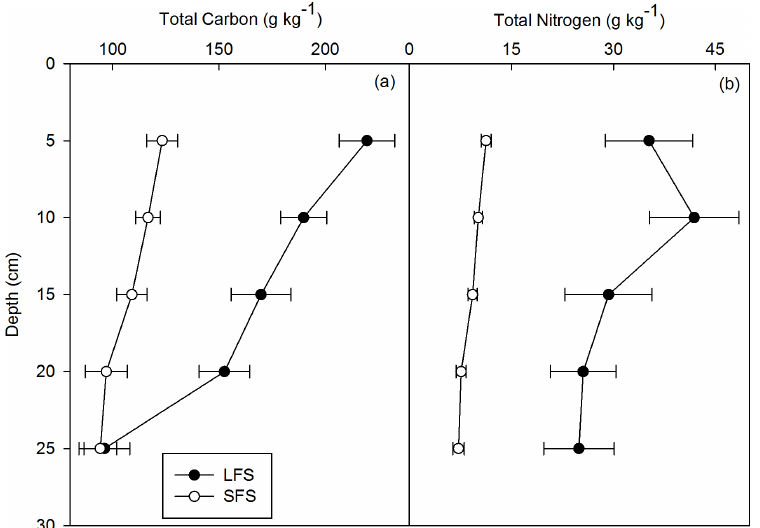
Figure 2. Profile of (a) total carbon and (b) total nitrogen in the LFS and SFS. Mean values ( n = 6) are for each level within a profile and the horizontal bars represent the standard errors.